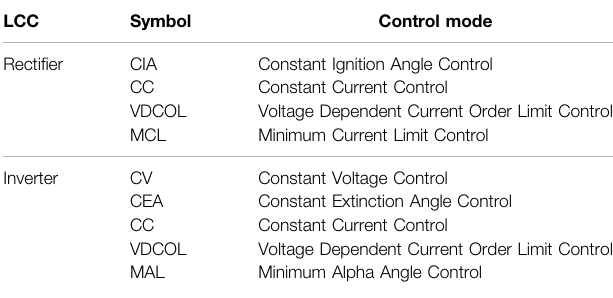
TABLE 1 | The control modes of LCC recti fi er and